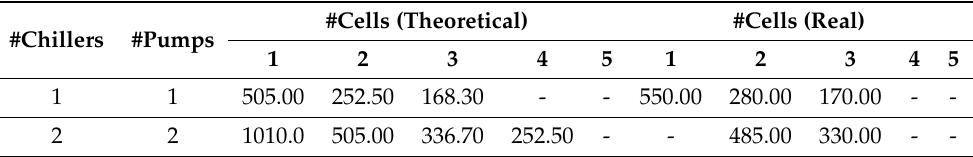
Table 2. Inlet flows for the cooling tower cells in m 3